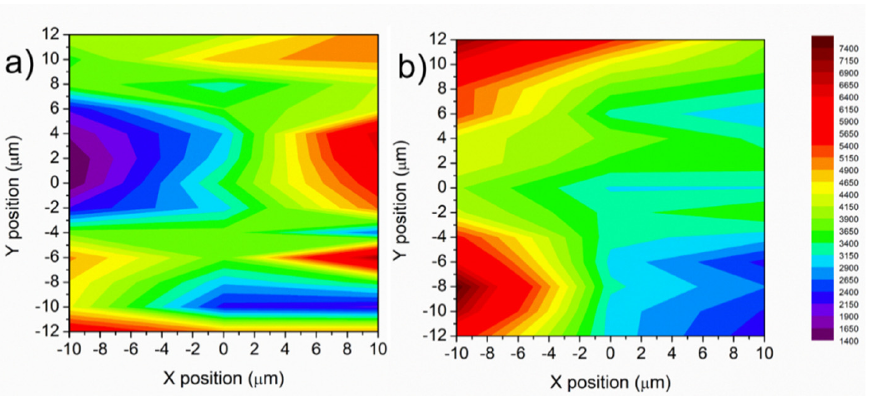
Figure 6. SERS intensity map image of 20 × 24 μ m 2 by lateral step of 2 μ m with 4 ‐ 4 ′ bipyridine concentration of 10 − 12 M based on characteristic peak at 1616 cm − 1 on ( a ) NPG and ( b ) 3 min A ‐ NPG. The reader is referred to the web version of this article for interpretation of the references to color in this figure legend.